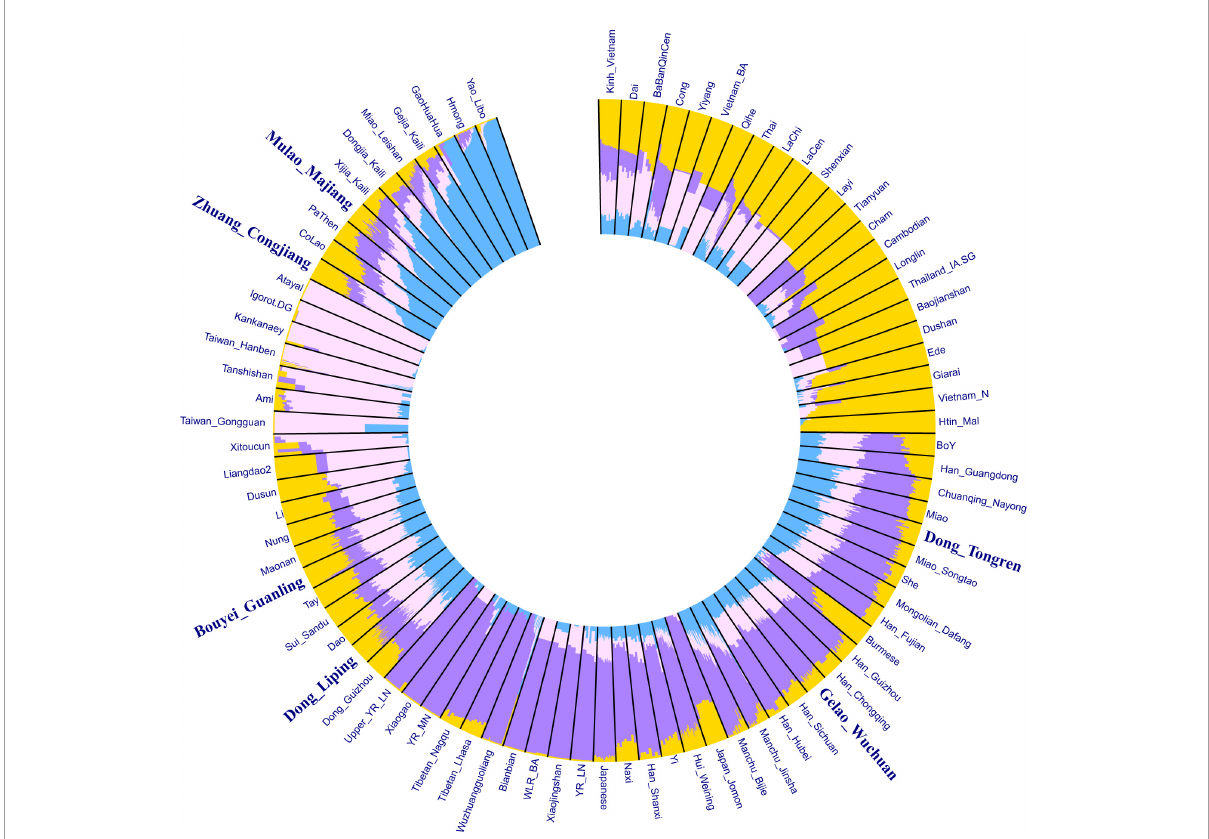
FIGURE2 HO-SNP-based ADMIXTURE analysis showed the admixture composition of the Tai-Kadai-speaking in Guizhou and other references ( K =